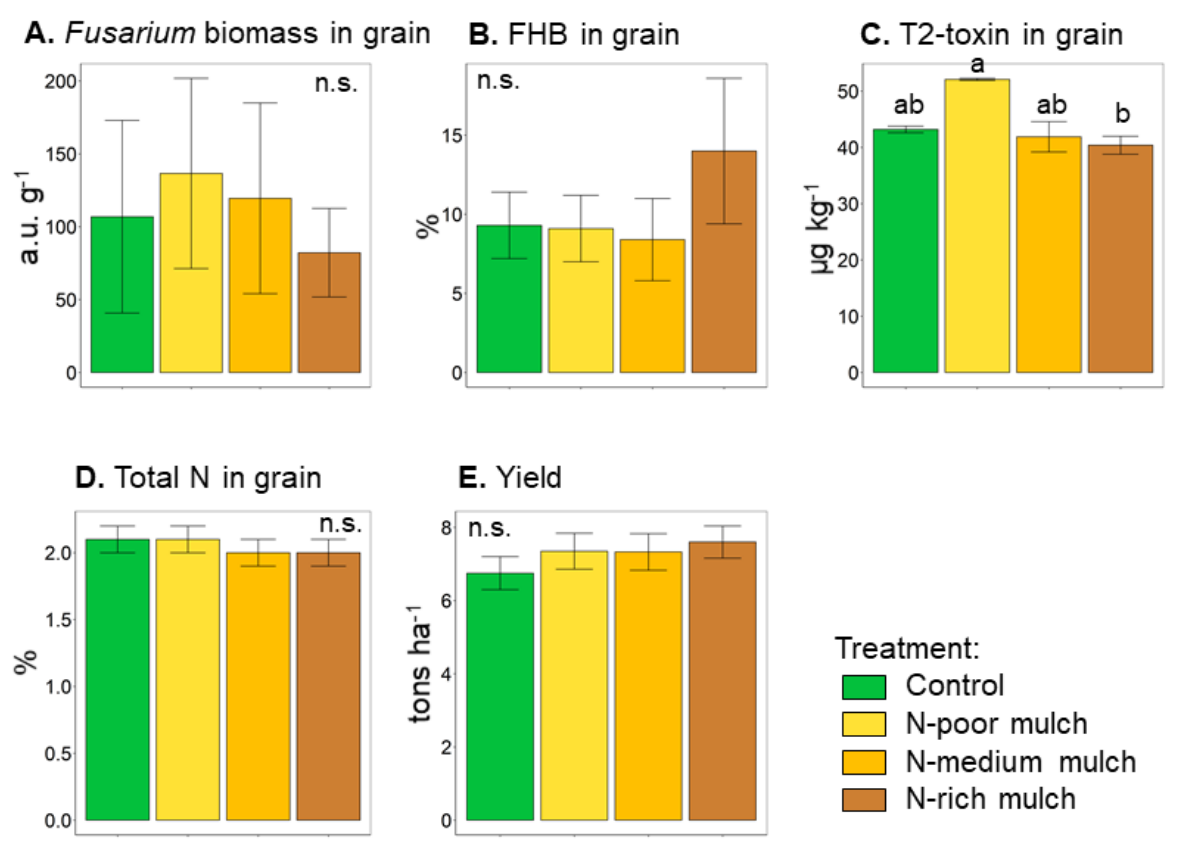
Figure 1. Estimates of the five FHB related study endpoints (mean ± 1 S.E., n = 5) from control (green bars), N-poor mulch (yellow bars), N-medium mulch (orange bars), and N-rich mulch (brown bars) treatments: ( A ) Fusarium biomass in grain, ( B ) FHB in grain, ( C ) T2-toxin in grain, ( D ) Total N in grain, ( E ) Yield. Different letters represent a significant difference between treatments (Kruskal-Wallis test and Dunn test, p < 0.05). No significant difference between treatments is denoted as “n.s.”. Table 2. Integral mean values and results of statistical comparison of measurements from experimen- tal treatments. Different letters represent a significant difference between treatments (Kruskal-Wallis test and Dunn test, p < 0.05). No significant difference between treatments is denoted as